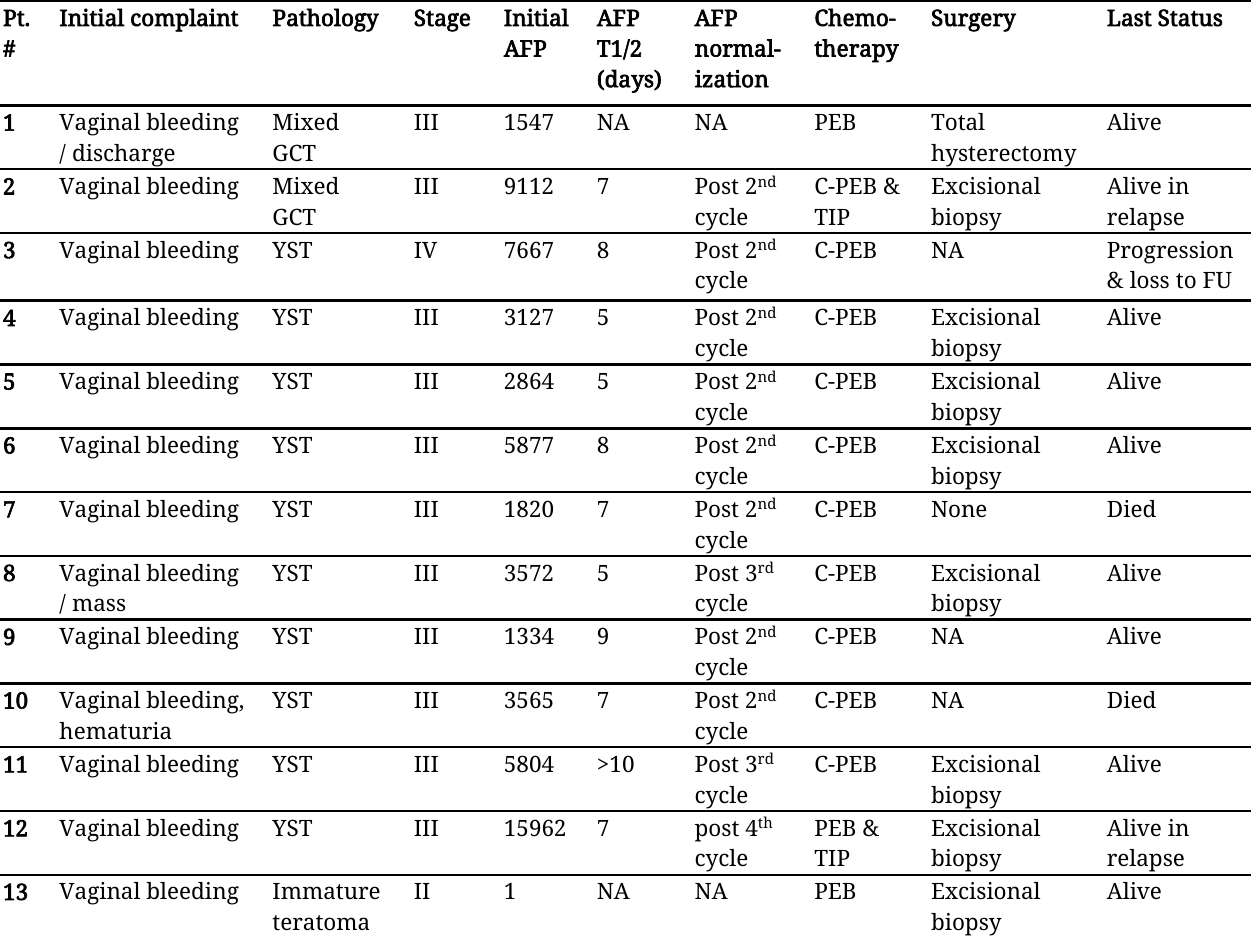
Table 2: Details of 13 pediatric patients with germ cell tumor